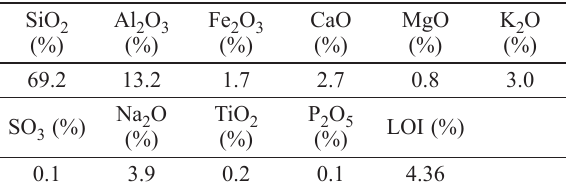
Table 3. Chemical composition of natural pozzolans (Espinoza et al. 2010)